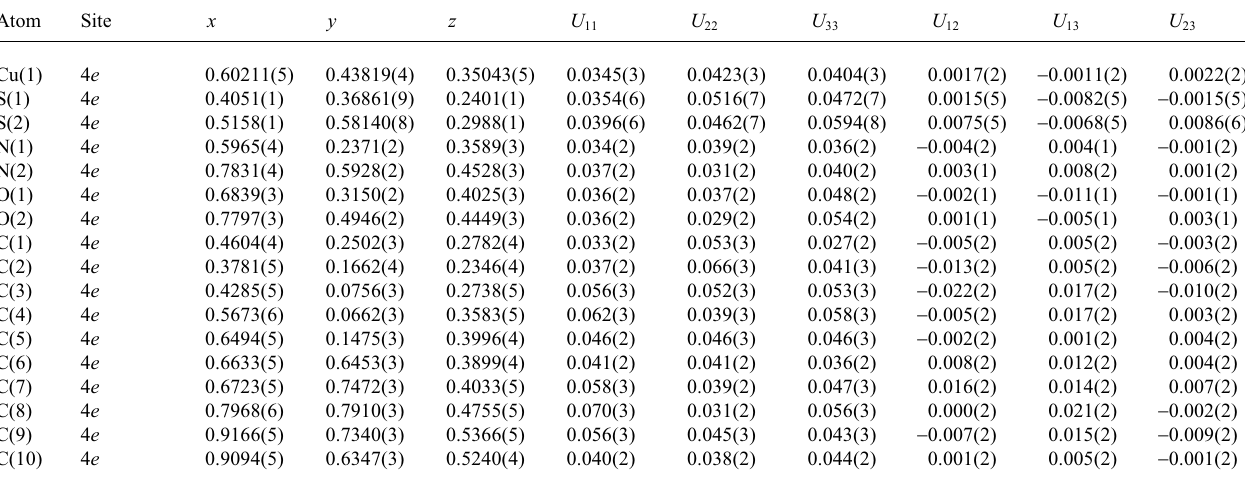
Table 3. Atomic coordinates and displacement parameters (in Å 2